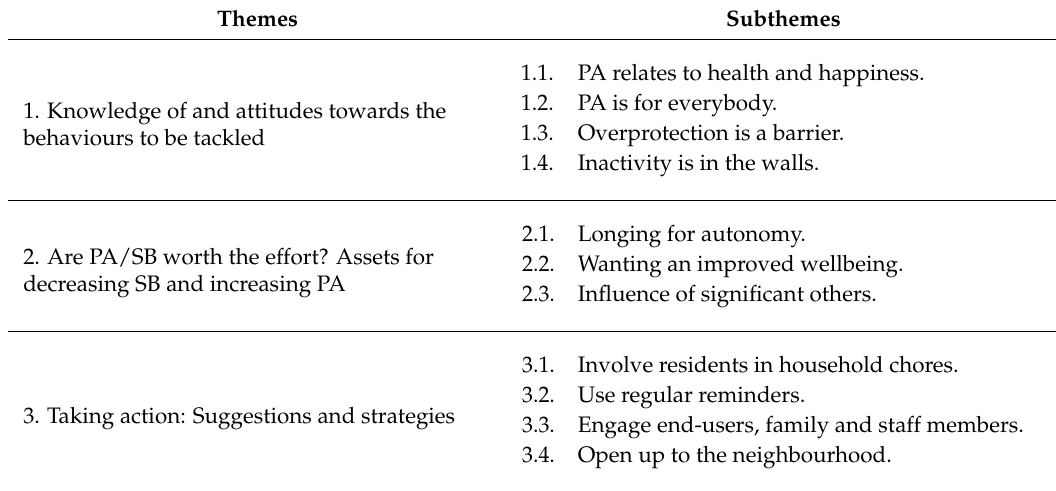
Table 2. Themes and subthemes of the 12